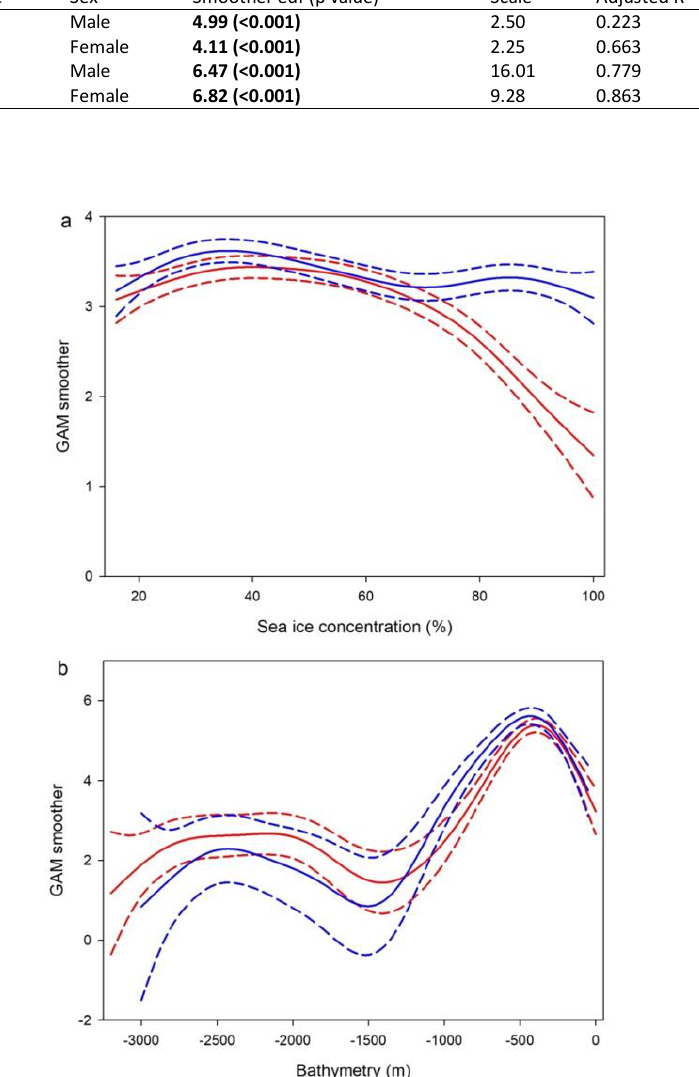
Figure 3. Foraging intensity habitat selection functions for (a) sea ice concentration and (b) bathymetry). Plots show the predicted curve from the model (solid line) and 95% confidence intervals (dashed lines) for male (blue) and female (red) snow petrels sampled at Ile des Pétrels, Adélie Land, East Antarctica. GAM: generalized additive model. Stable isotope